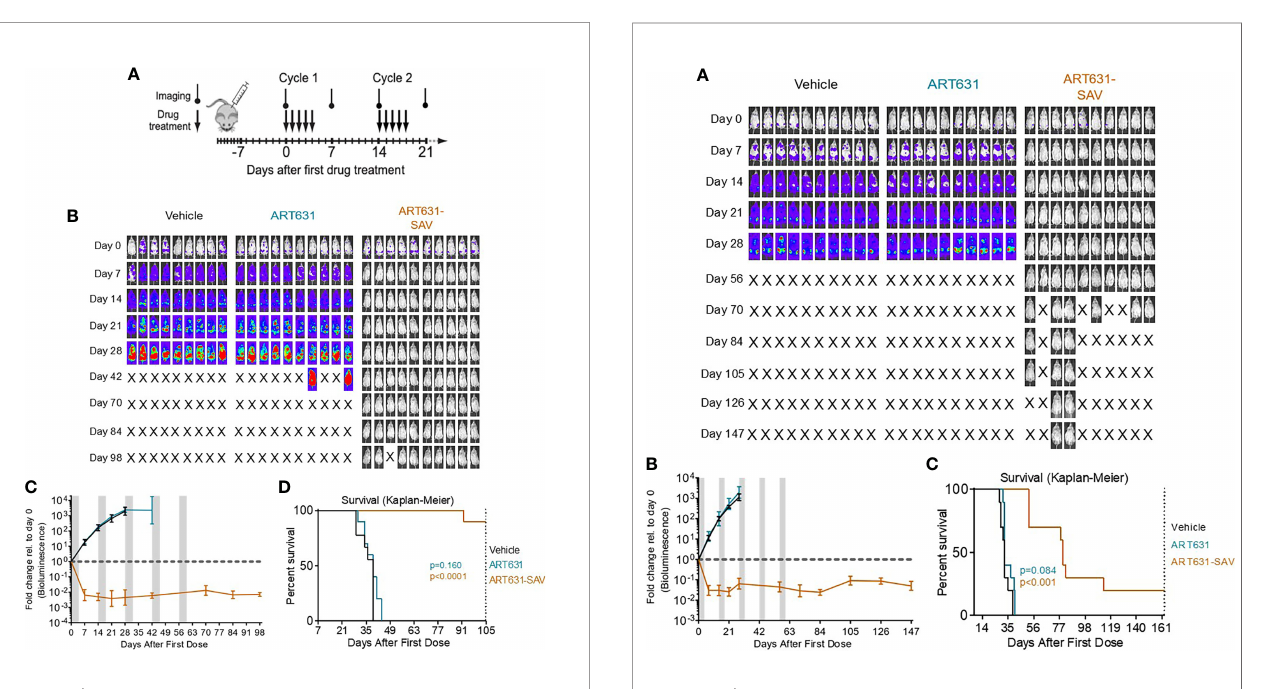
FIGURE 8 | VEN plus SOR plus ART631 induced deep, long remissions in AML xenografts. (A) NRG mice were transplanted IV with Luc-labeled MOLM14 cells on day -10. After Xenogen quanti fi cation of baseline total body luminescence on day 0, mice were placed into balanced experimental groups prior to drug administration via gavage, then treated per our previously established MTD PO x 5 day schedule (5 days on, 9 days off). Mice were treated with 15 mg/kg/d ART631 as monotherapy or in combination with 150 mg/kg/d VEN and 30 mg/kg/d SOR for 5 identical 5-day treatment cycles over 10 weeks. These xenograft experiments with ART631 and ART631- containing SAV were performed simultaneously with those with ART838 and ART838-containing SAV reported previously (20). Treatment response outcomes were measured by (B) leukemia response quantitation (fold-change in leukemia burden on day 7 (and later) vs day 0 for each mouse via Xenogen imaging (grey-shaded bands on graphs indicate days when mice were treated). Error bars represent SD of fold-change in leukemia burden of mice in each treatment group. (C) shows corresponding Kaplan-Meier survival curves. Mouse deaths empirically de fi ned to have occurred for reasons other than leukemia (i.e. deaths of mice with luminescence at or below average background luminescence (5.7x10 5 photons/mouse based on intensity values from non-leukemia bearing mice) were censored. Comparisons between treatment groups were calculated by log-rank (Mantel-Cox)